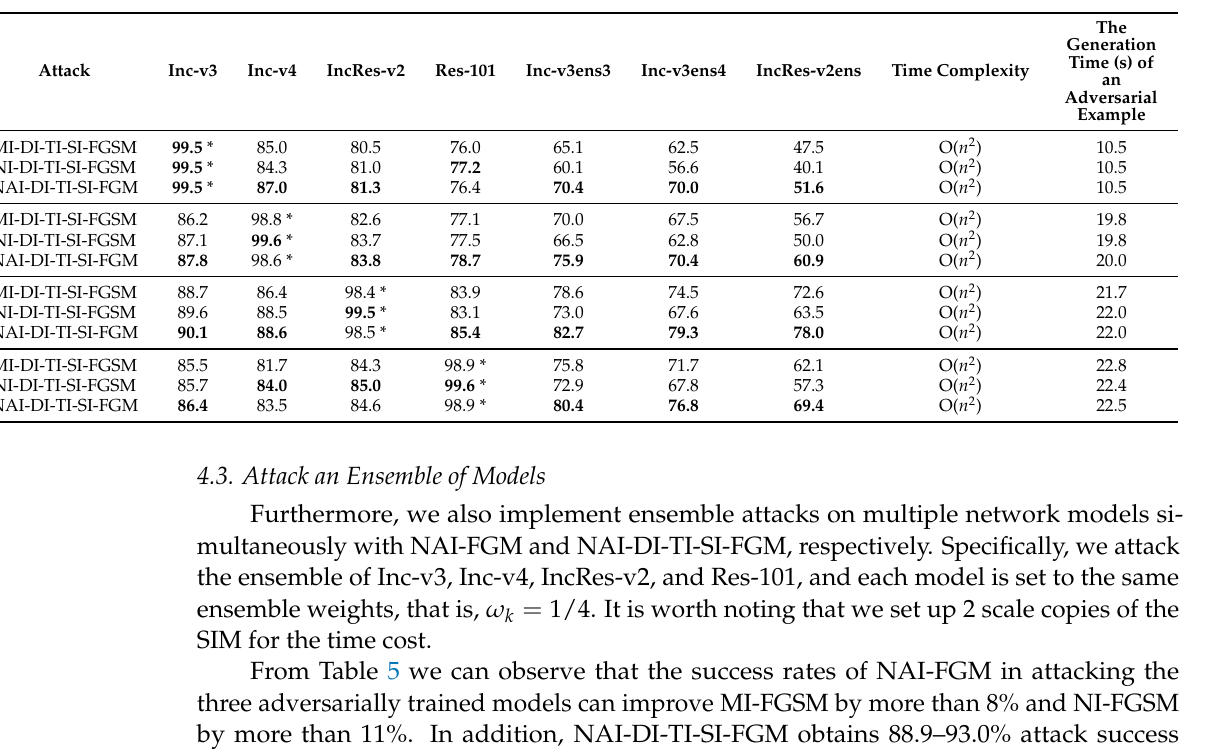
Table 4. Comparison of the success rates (%) of attacking a single model by three momentum-based iterative attacks with input transformations. * indicates the white-box